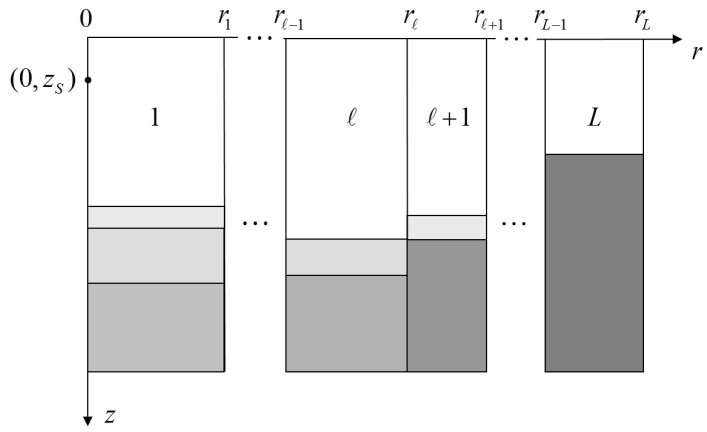
Figure 1. Range segmentation for coupled-mode formulation.